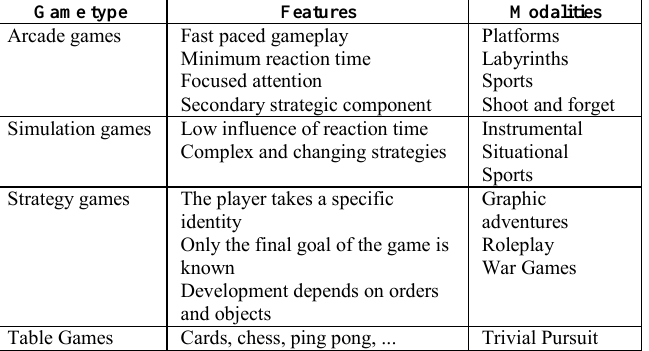
Cards, chess, ping pong, ... Trivial